Question: Summarize what this figure shows in one sentence.
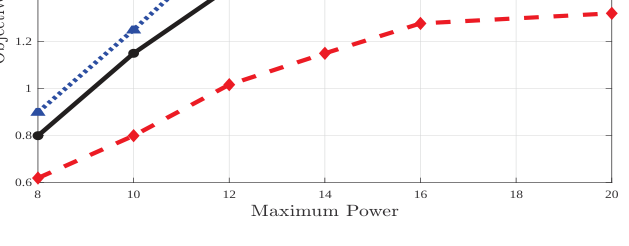
Answer: The objective versus maximum transmit power with α = 0.5.